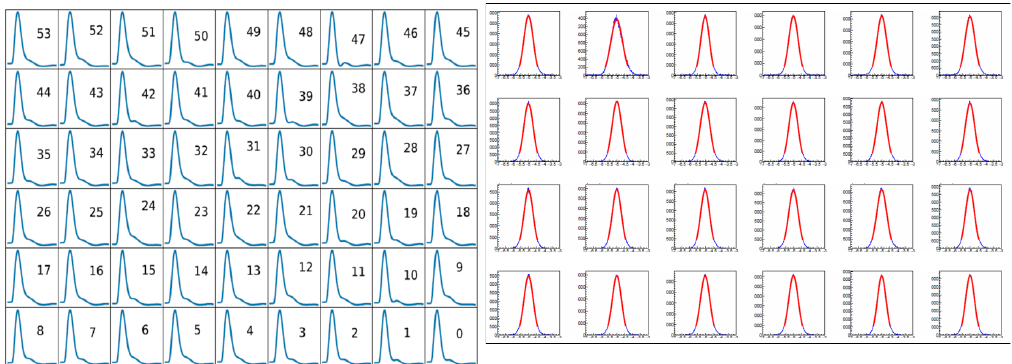
Figure 6. ( Left ) The customized pulse shape fitting of all 54 crystals of a calorimeter; and ( Right ) the time resolution measurements fitted with a Gaussian function form for each